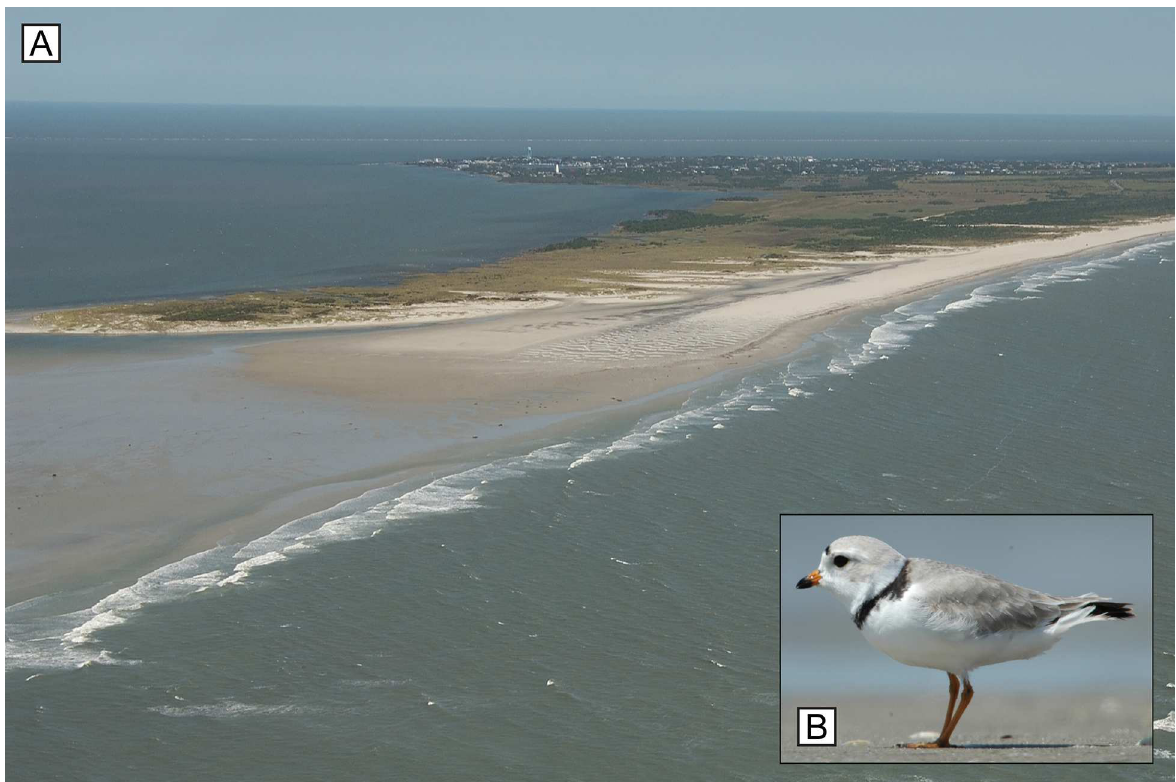
Fig 1. Barrierislands are a principal habitat type in the U.S. Atlantic coast piping plover breeding range. (A) Oblique aerial photograph of southwestern Ocracoke Island, North Carolina,showingopen-oceansandy beach (right), dunes, backbarrierbay, and various types of dune, shrub, forest, and marsh vegetation. (U.S. Geological Survey/photo by Karen L.M. Morgan.) (B) The piping plover ( C . melodus ), a federally listed beach-nesting shorebird. (U.S. Fish and Wildlife Service/photo by Gene Nieminen.)